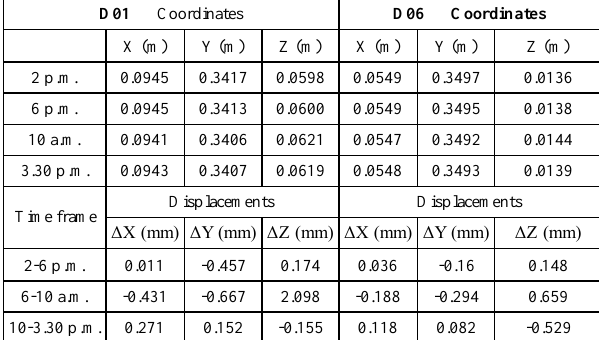
Table 2. Coordinates and displacements of the